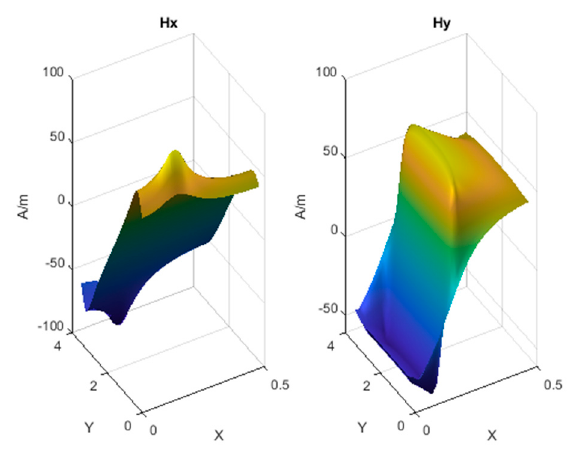
. H x y . ( , ) H x y and ( , ) y x